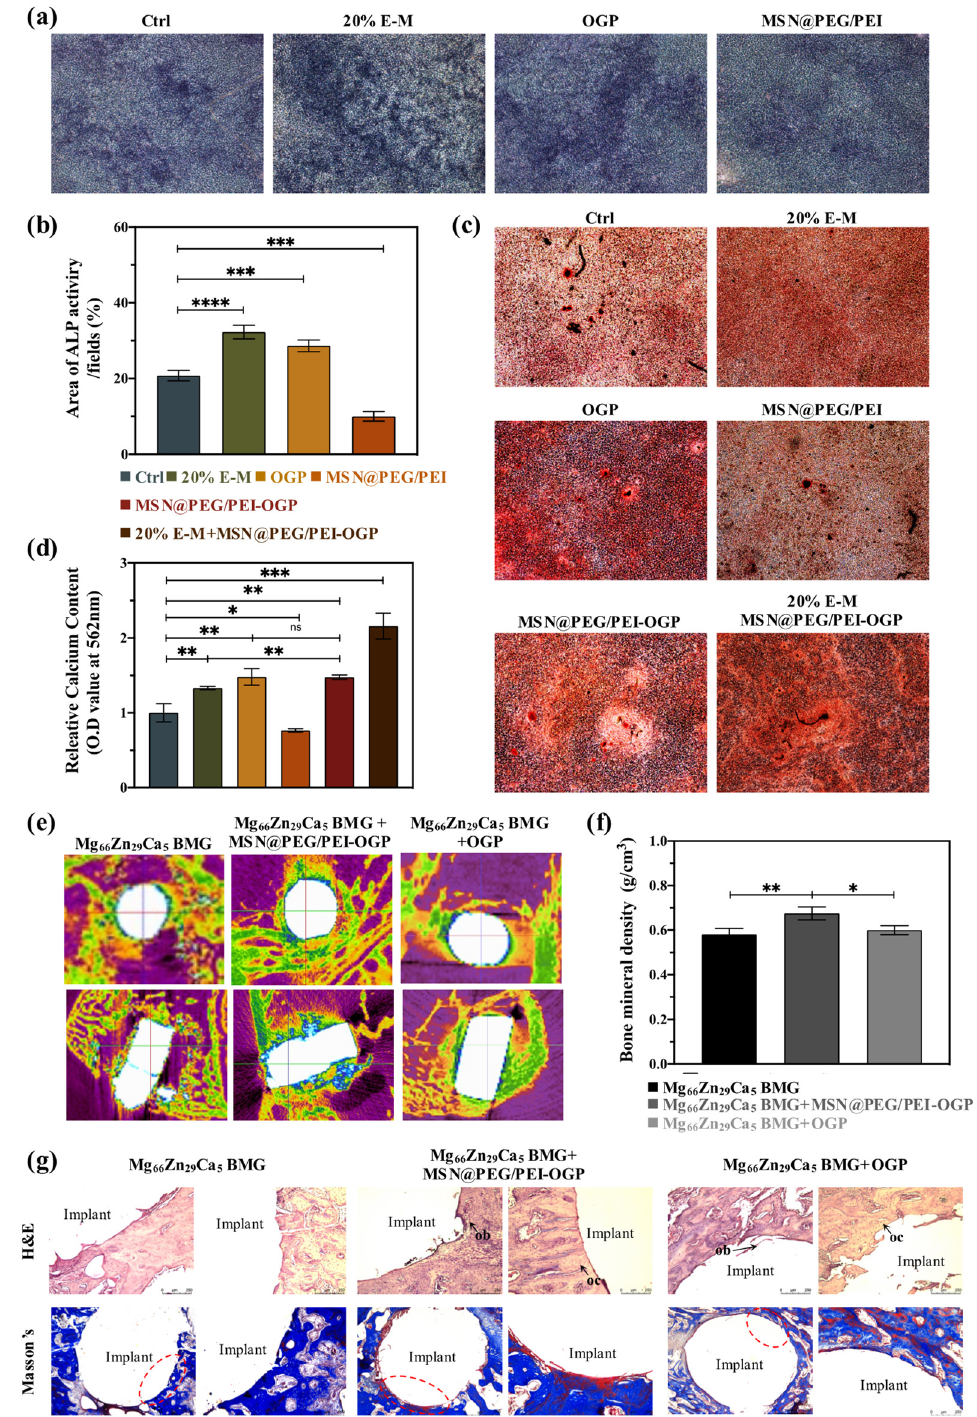
Figure 4. ( a ) Alkaline phosphatase (ALP) activity of induced − MC3T3-E1 cells under different conditions after 14 days of culture. ( b ) Quantitative assay for ALP activity. ( c ) Alizarin red s (ARS) staining of induced-MC3T3 − E1 cells after 21 days of culture. ( d ) Quantitative assay for ARS staining. ( e ) Micro − CT image of a distal rabbit femur at 4 weeks post − surgery. ( f ) Quantitative assay for the bone mineral density of distal rabbit femurs surrounding the implant site at 4 weeks post − surgery. ( g ) H&E staining and Masson’s trichrome staining of tissues surrounding the implant site. ob, osteoblasts; oc, osteocytes. Type I collagen was stained blue and mature bone was stained red. The concentration of nanoparticles was 100 μ g/mL. ( n = 3 per group). (Data are the mean ± standard deviation, * p < 0.05, ** p < 0.01, *** p < 0.001, **** p < 0.0001).